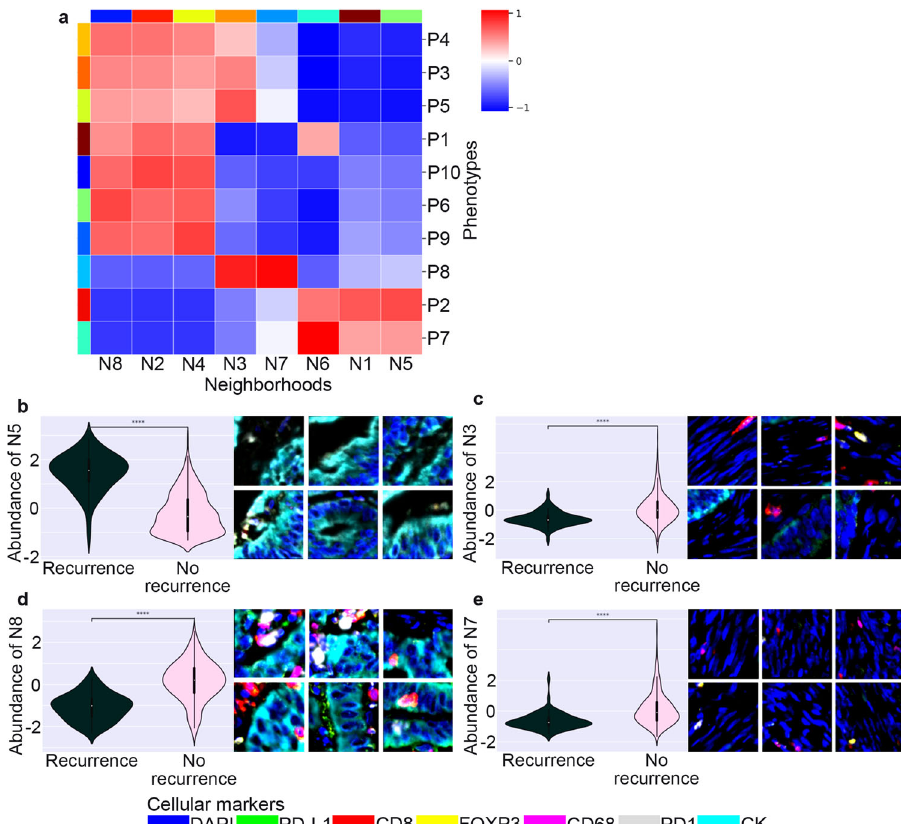
Fig. 4 Interpretability of cellular neighborhoods. a Heatmap showing the eight conserved, distinct cellular neighborhoods (N1 – 8) composed of the proximity of the 12 most adjacent local phenotypes (P1 – 8). For visualization, relative abundances of local phenotypes were normalized by columns; the maximum value for each local phenotype in a neighborhood is one. b The six most representative images from cellular neighborhood N5. N5 was more associated with tumors with recurrence and represented regions enriched with tumor cells with variable PD-L1 expression and no immune cell in fi ltration. Relative abundance of cellular neighborhood N5 is shown. c – e The six most representative images from cellular neighborhoods (N3, N7, and N8) are more associated with tumors with no recurrence. N3 shows discrete immune cell in fi ltrates characterized by CD8, PD-1, FOXP3, CD68, and PD-L1. N7 is enriched with cells with elongated nuclei expressing none of the markers (possibly stromal cells) with discrete immune cell in fi ltrates. N8 shows higher immune cell in fi ltration with CD8, FOXP3, and CD68. Relative abundances of cellular neighborhoods N3, N7, and N8 are shown. Data were analyzed using a two-sided Mann – Whitney – Wilcoxon test with Bonferroni correction. ****, P values: N3 = 2.87e-11, N5 = 1.57e-29, N7 = 3.51e-12, and N8 =